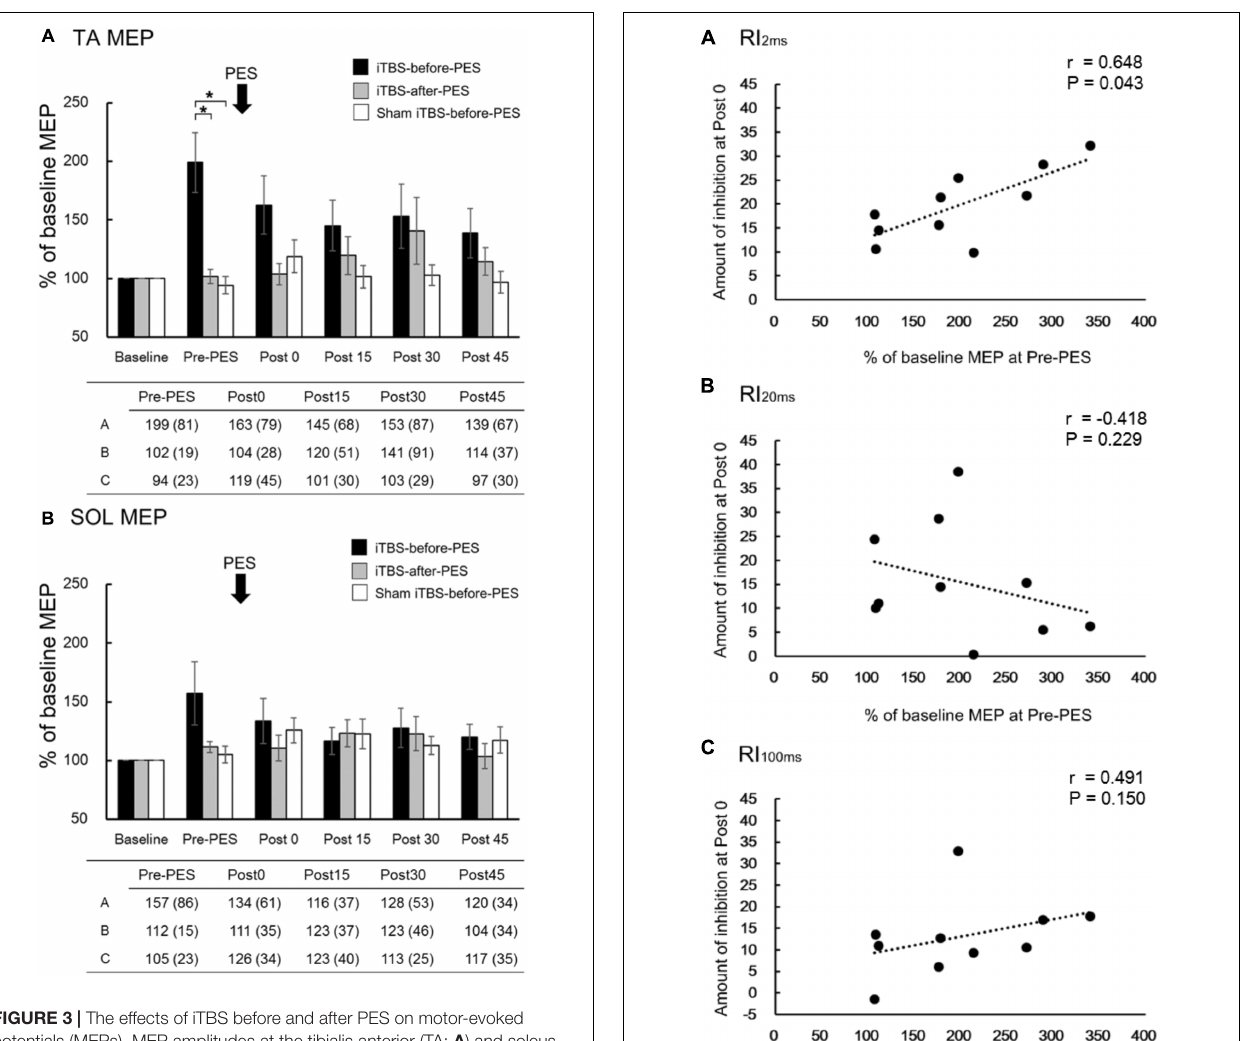
FIGURE 3 | The effects of iTBS before and after PES on motor-evoked potentials (MEPs). MEP amplitudes at the tibialis anterior (TA; A ) and soleus (SOL; B ) muscles were normalized to the baseline amplitude (%) for each paradigm. The values (%) in the figures are presented as the mean ± standard error. The tables show the mean ( ± SD) for iTBS-before-PES (A) , iTBS-after-PES (B) , and sham iTBS-before-PES (C). Asterisks indicate significant differences ( P < 0.05) among the interventions.